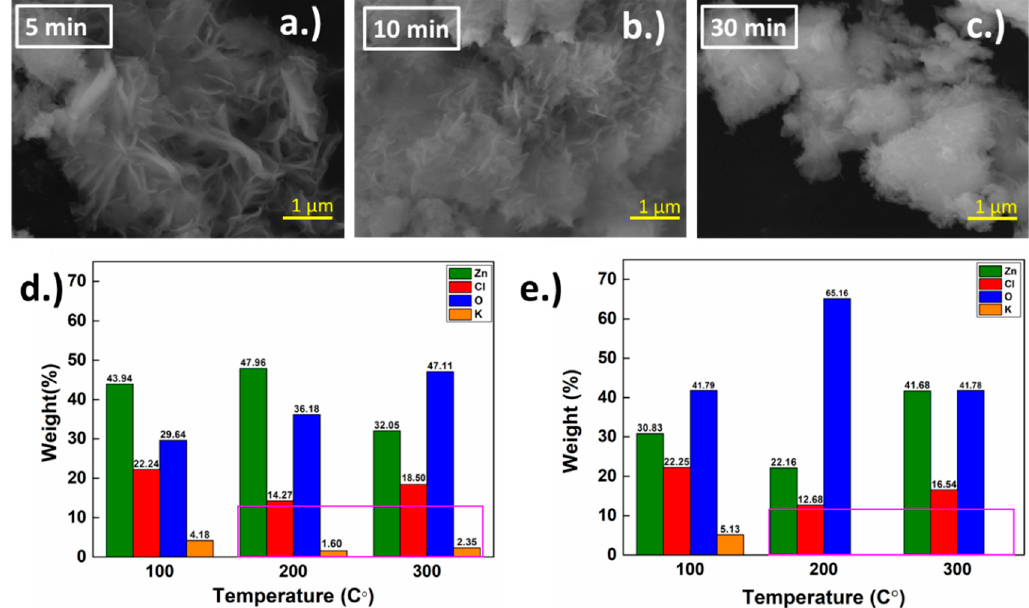
Figure 2. Scanning electron microscope (SEM) images of the extracted crystal grown for ( a ) 5; ( b ) 10 and ( c ) 30 min and electron diffraction spectroscopy (EDS) results of ZnO crystals grown (with K element as weighing factor in pink rectangle) for ( d ) 5 and ( e ) 30 min).